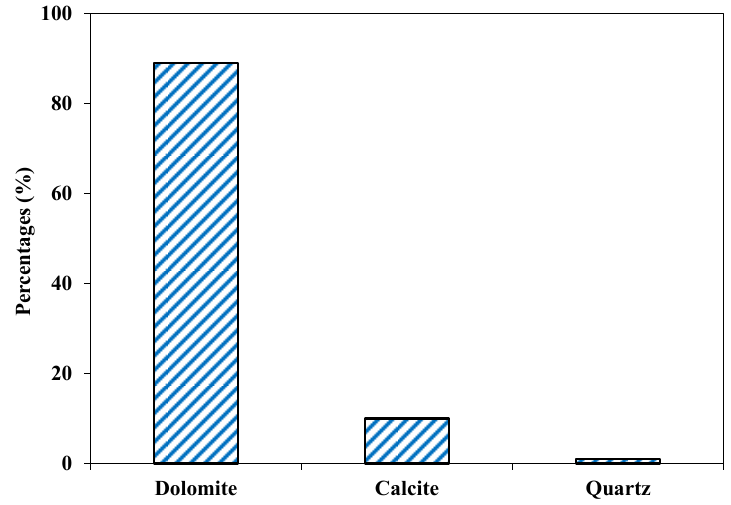
Figure 9. Mineralogical composition of Swabi aggregate.